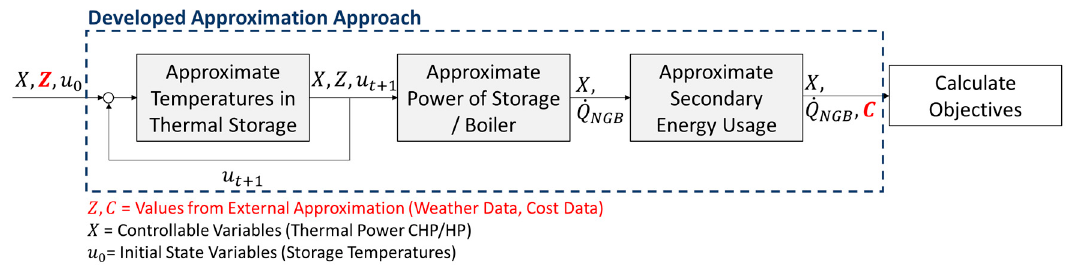
Figure 3. Schematic representation of the developed multi-stage approximation of the objectives for MPC.